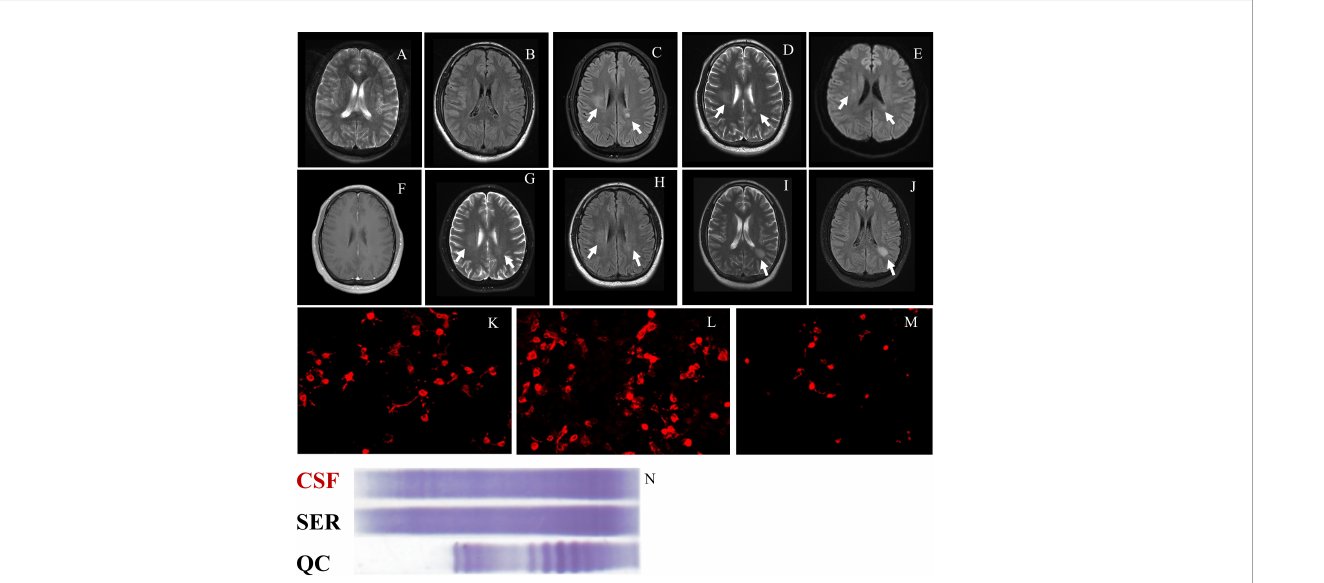
FIGURE 2 Brain MRI and antibodies in this case. (A) and (B) The MRI performed in October 2021 demonstrated normal results on T2 weight imaging and FLAIR imaging. (C – E) The MRI result showed signi fi cant hyperintensity in the right semioval center and the left posterior horn of the lateral ventricle on FLAIR imaging, T2 weight imaging, and DWI on June 1, 2022. (F) Enhanced magnetic resonance imaging performed on June 1, 2022, not showing a signi fi cant lesion. (G) and (H) The results of the MRI performed on June 1, 2022 demonstrated that the hyperintensity lesions were alleviated than before on T2 weight imaging and FLAIR imaging. (I) and (J) The results of the MRI performed on October 1, 2022 showed a new lesion with hyperintensity in the left posterior horn of the lateral ventricle on T2 weight imaging and FLAIR imaging. (K, L) Anti-NMDAR antibodies were found to be positive in serum (1:100) and in CSF (1:30) on June 1, 2022. (M) Anti-NMDAR antibodies were found to be positive in CSF (1:10). (N) OB was positive in CSF (counts, ≥ 2). CSF, cerebrospinal fl uid; DWI, diffusion-weighted imaging; FLAIR, fl uid-attenuated inversion recovery; MRI, magnetic resonance imaging; OB, oligoclonal immunoglobulin bands; anti-NMDAR, anti-N-methyl-D-aspartate receptor; QC, quality control; SER,